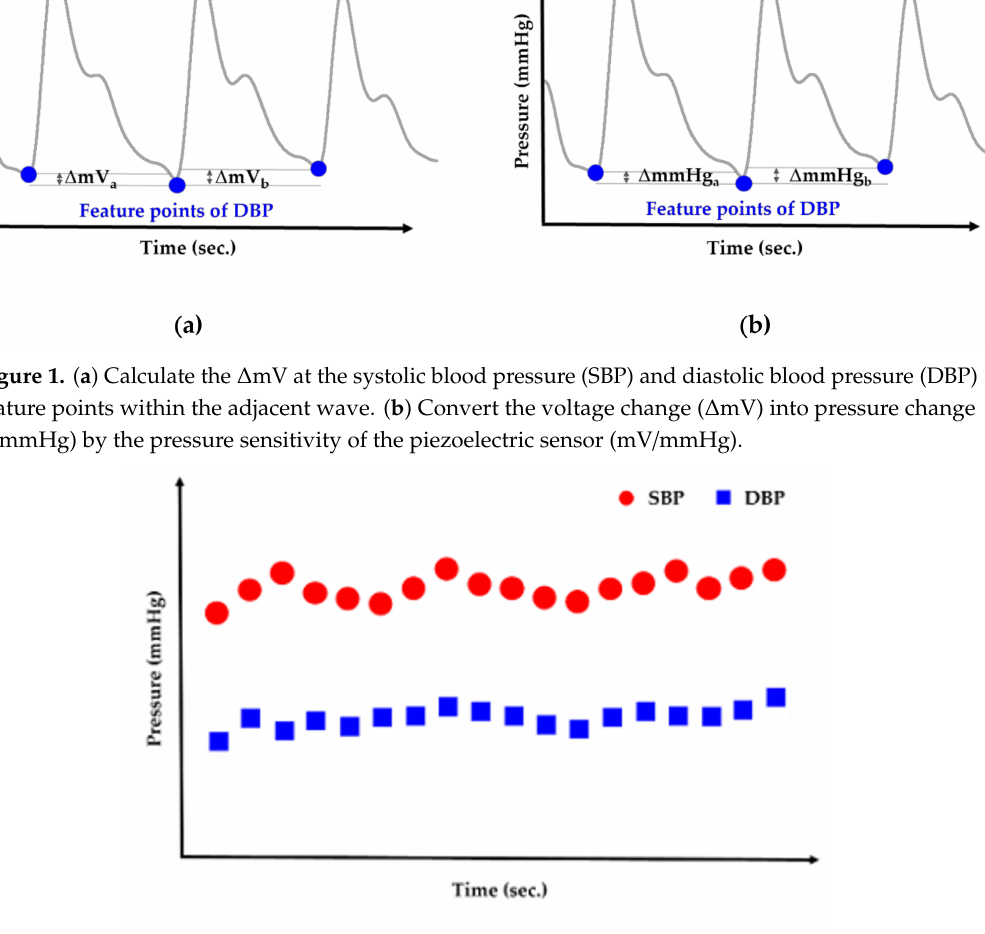
Figure 2. Continuous beat-to-beat SBP and DBP